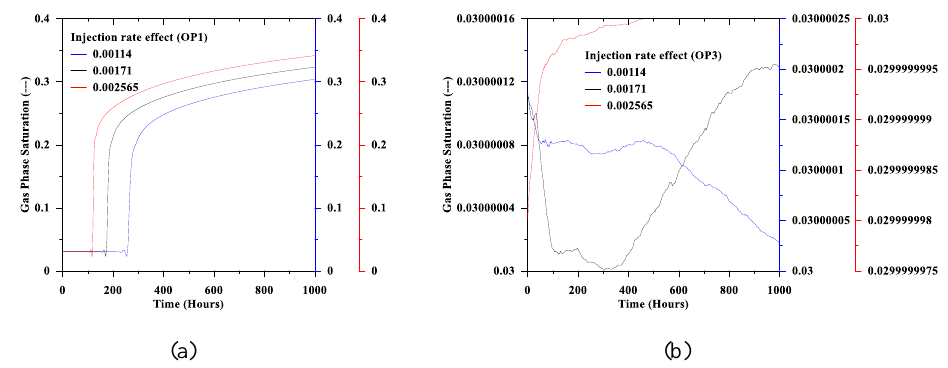
Figure 18. Injection rate effect on the gas saturation: ( a ) OP1 and ( b ) OP3.